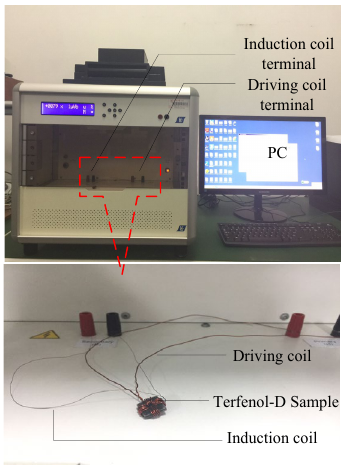
Figure 1. Dynamic-hysteresis-loop measurement system. The signal generator and power amplifier provide an alternating magnetic field for the driving coil. The induced electromotive force is generated in the induction coil. The magnetic field in the Terfenol-D sample is obtained from the voltage on sampling